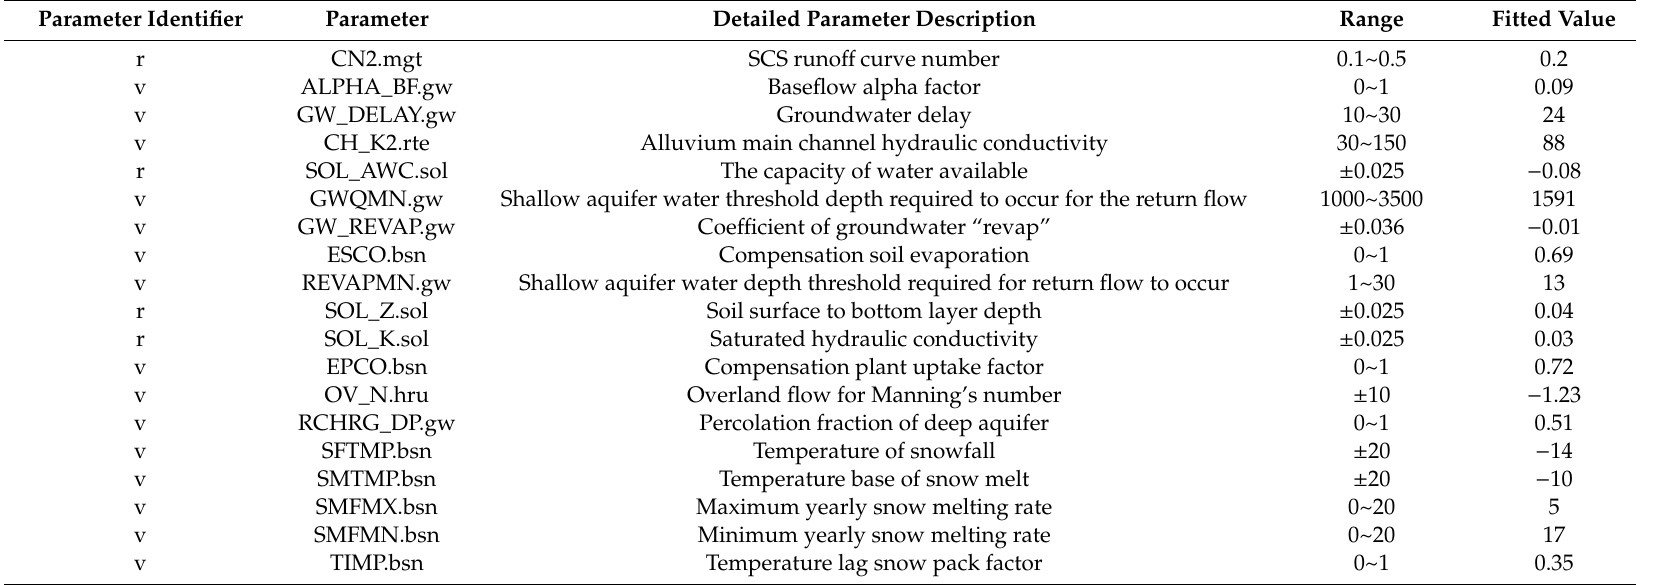
Table 3. Model calibration parameters.